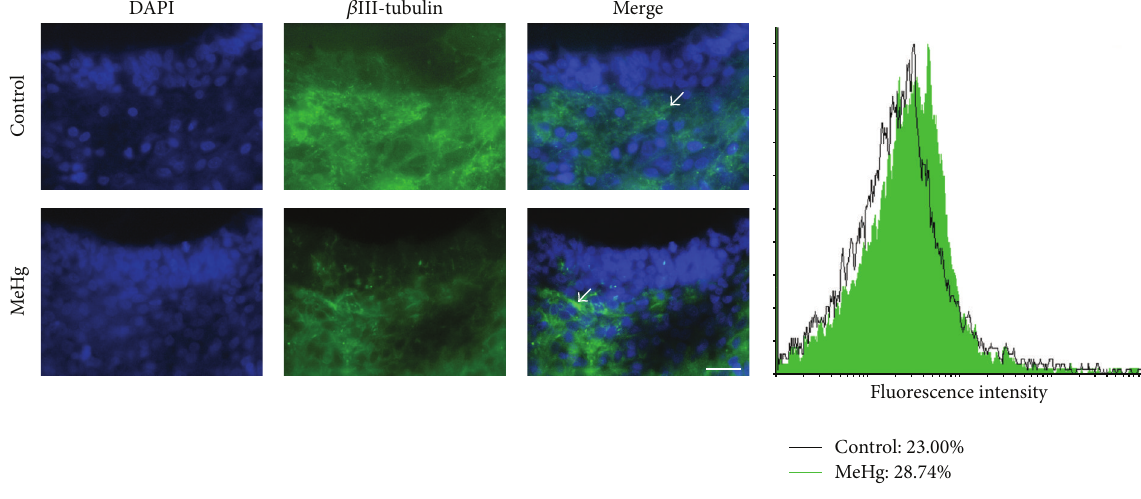
Figure 7: 𝛽 III-tubulin protein analyzed by immunohistochemistry and flow cytometry. 𝛽 III-tubulin-positive cells (white arrows) observed mainly in the mantle layer. The graph displays the expression profile and relative frequency of 𝛽 III-tubulin in the spinal cord of the control and MeHg-treated embryos. Scale bar: 20 𝜇 m.